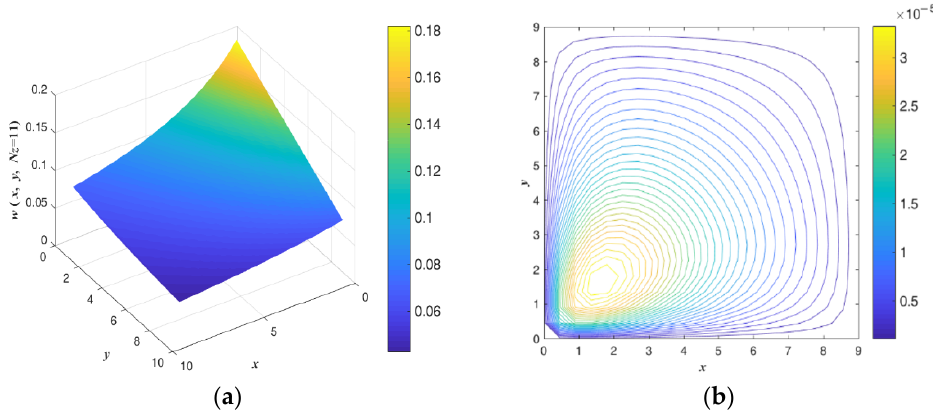
Figure 17. Potential distributions for a nonlinear Helmholtz problem: ( a ) numerical solution; ( b ) absolute errors.